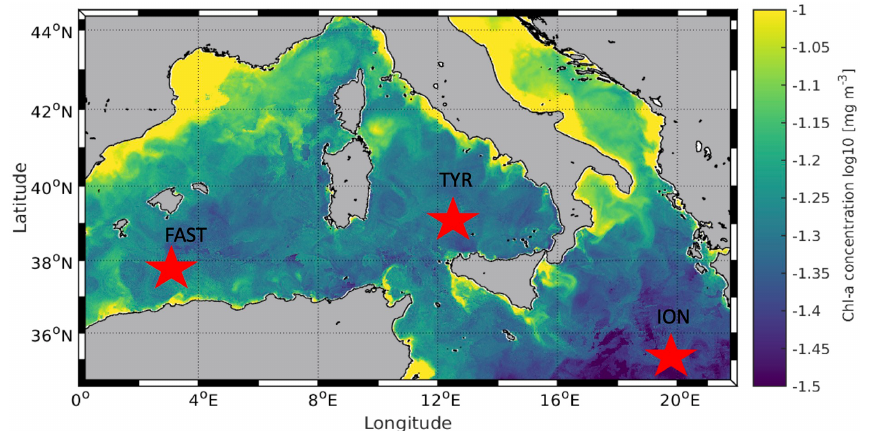
Figure 1. Location of the sampling stations in the Mediterranean Sea on board the R/V Pourquoi Pas? during the PEACETIME cruise (10 May to 11 June 2017). Background shows satellite-derived surface chlorophyll a concentration averaged over the entire duration of the cruise (courtesy of Louise